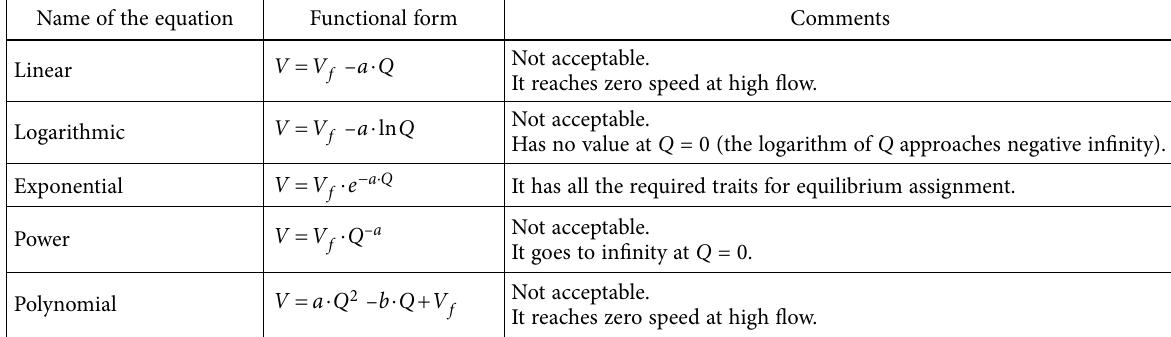
Table 1. Functional form of contestant equations for speed–flow